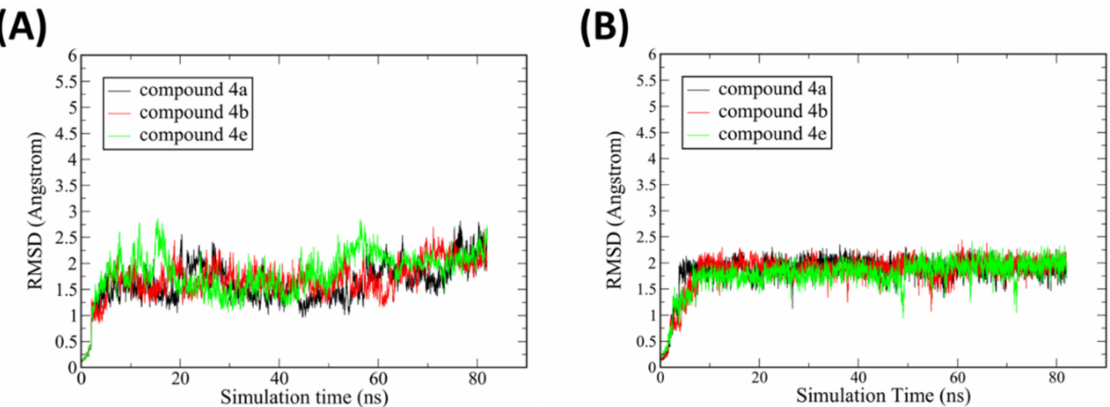
Figure 8. Time evolution of RMSD of the entire trajectory consisting of structures sampled in intervals of 20 ps. The plot depicts RMSD values based on ( A ) protein backbone atoms and ( B ) ligand heavy between the trajectory frames and the starting